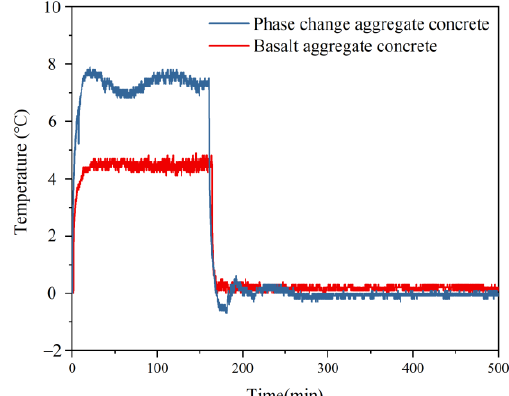
Figure 16. The temperature difference between inner and outer surfaces of concrete slabs.